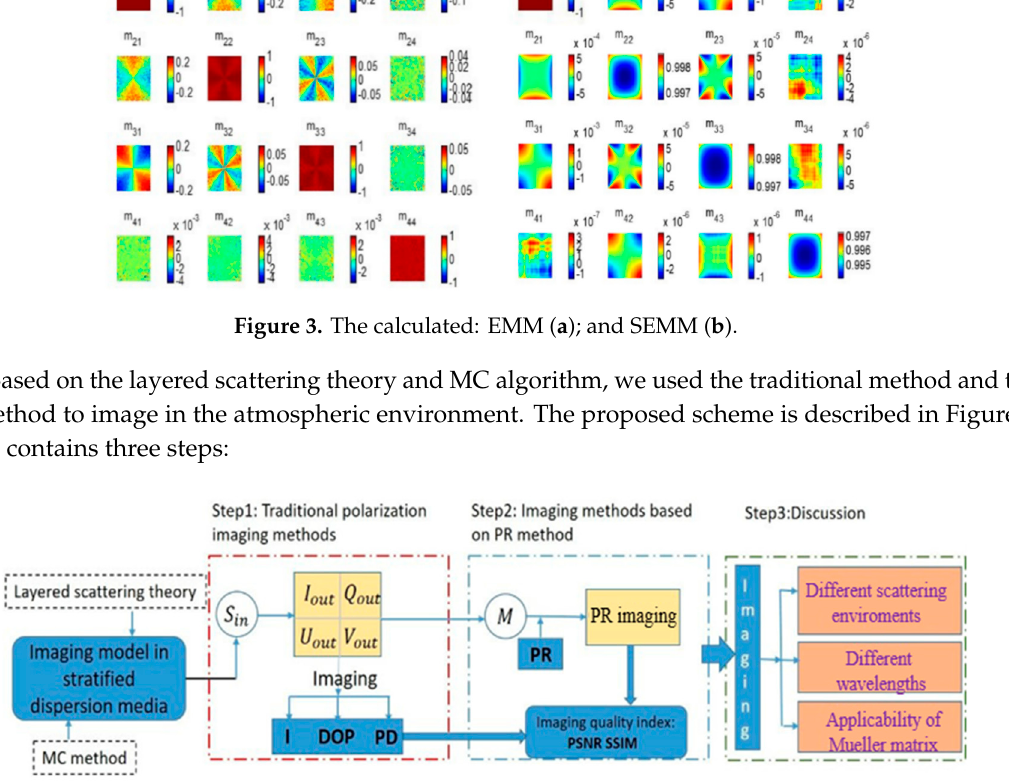
Figure 4. Different polarization imaging method in stratified dispersion media. Figure 4. Di ff erent polarization imaging method in stratified dispersion